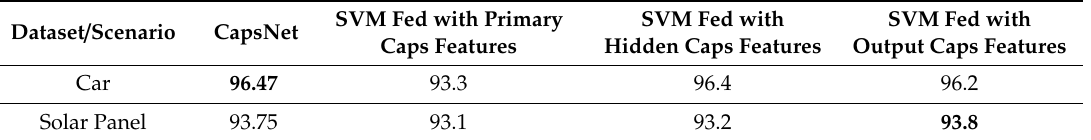
Table 9. Classification accuracies (%) obtained by the CapsNet and the SVM classifier fed with features from di ff erent layers of the network with an extra hidden layer.